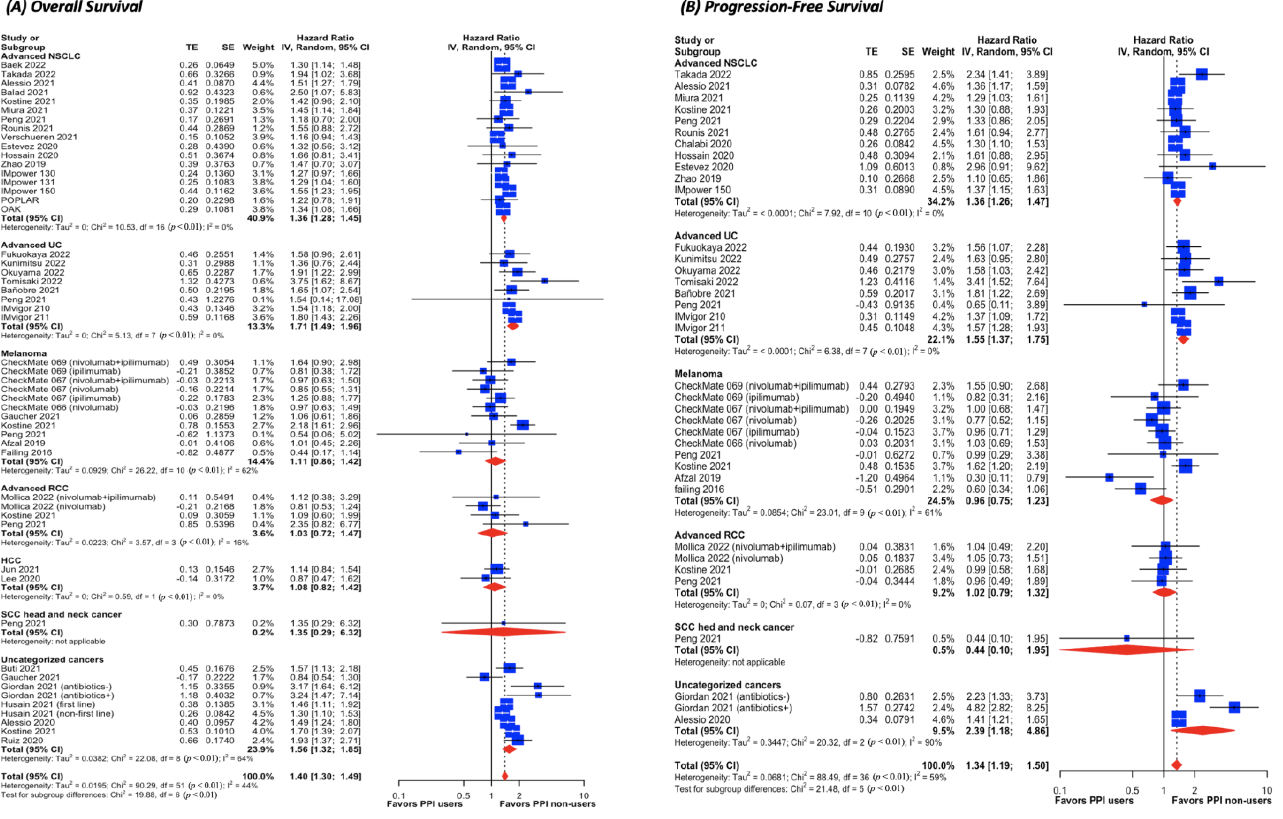
Figure 3. Forest plot of comparative ( A ) overall survival and ( B ) progression-free survival in cancer patients treated with ICI between PPI users and non-users. The size of squares is proportional to the weight of each study. Horizontal lines indicate the 95% CI of each study; diamond, the pooled estimate with 95%; CI, confidential interval; HCC, hepatocellular carcinoma; HR, hazard ratio; NSCLC, non-small cell lung cancer; PPI, proton pump inhibitor; RCC, renal cell carcinoma; SCC, squamous cell carcinoma; and UC, urothelial carcinoma.